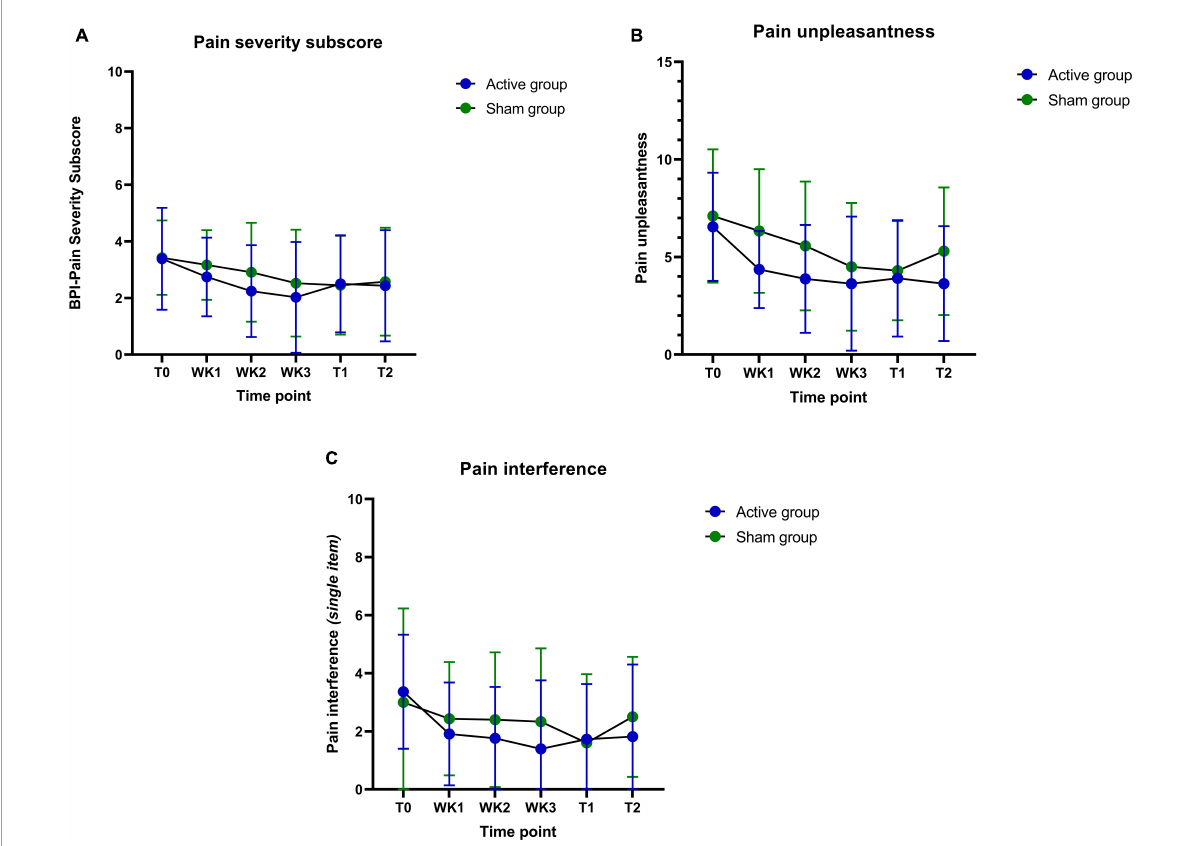
FIGURE6 (A–C) Pain severity, pain unpleasantness, and pain interference (baseline: T0; weekly: WK1-WK3; post-intervention: T1 and the follow-up: T2) measures during the training